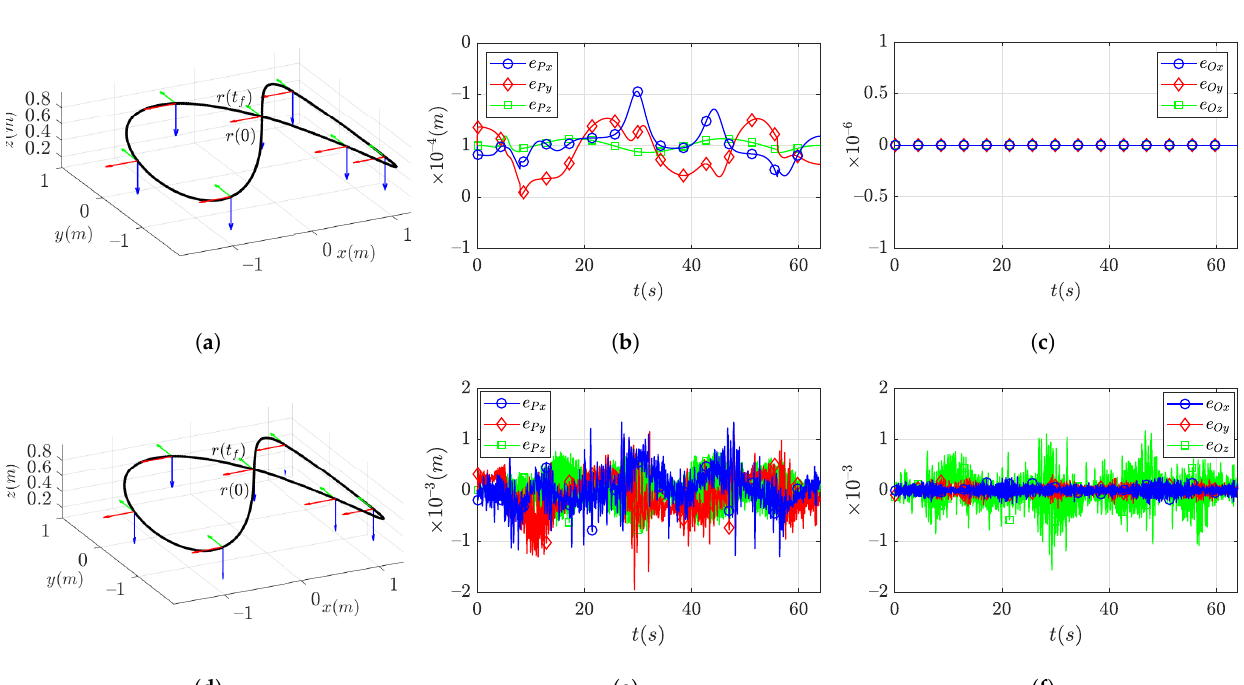
Figure 7. Tracking performance comparison between simulations and experiments for the Lissajous trajectory. End-effector’s trajectory in simulations ( a ) and experiments ( d ). Position errors in simulations ( b ) and experiments ( e ). Orientation errors in simulations ( c ) and experiments ( f ). Notice that the position and orientation errors, panels ( b , c ), respectively, are small in the simulations. In addition, notice that the trajectories in simulations ( a ) and experiments ( b ) are quite similar. The reason for the larger errors obtained in the experiments (panel ( e , f )) are discussed in Section